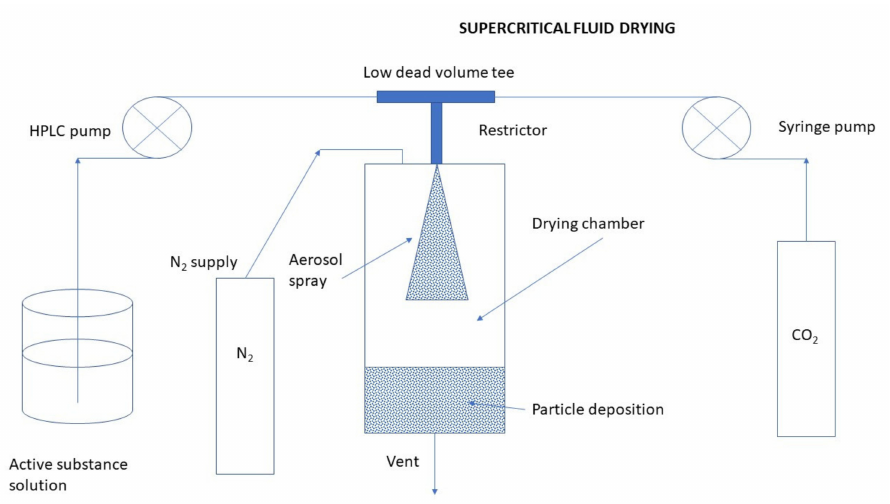
Figure 10. Preparation of CS NPs by the supercritical fluid drying